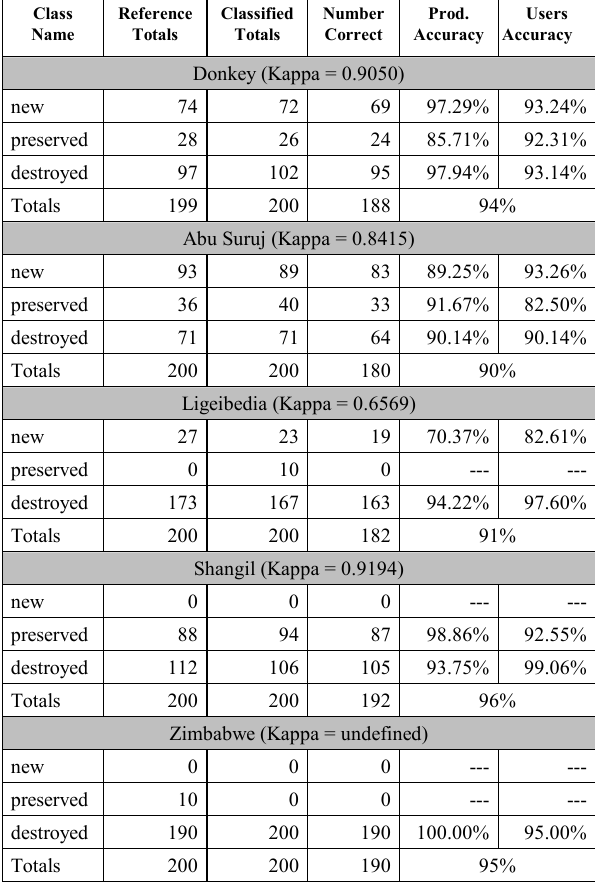
Table 2. Results of the Accuracy Assessment